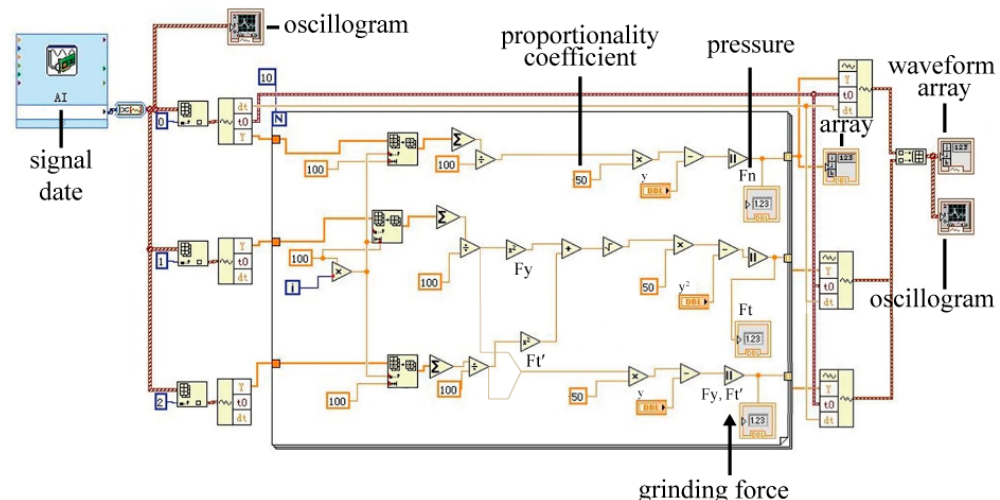
Figure 5. Labview program of force measurement system.